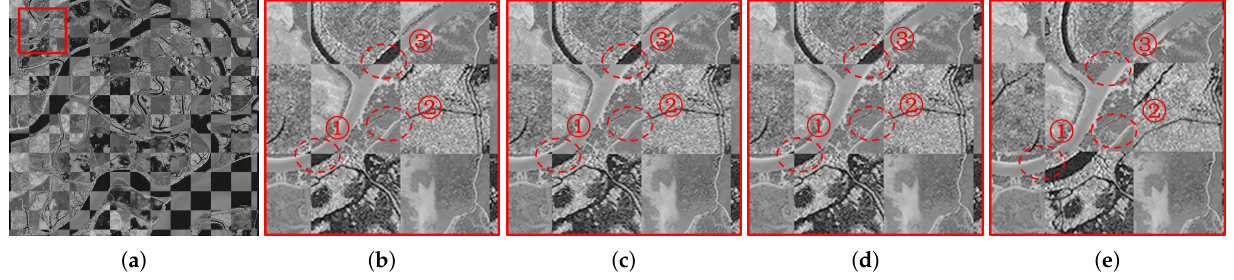
Figure 21. Checkboard mosaic image and enlarged sub-images of Pair D: ( a ) checkboard mosaic image of HOPES; ( b – e ) enlarged sub-images of HOPES, CFOG, HOPC, OS-SIFT.